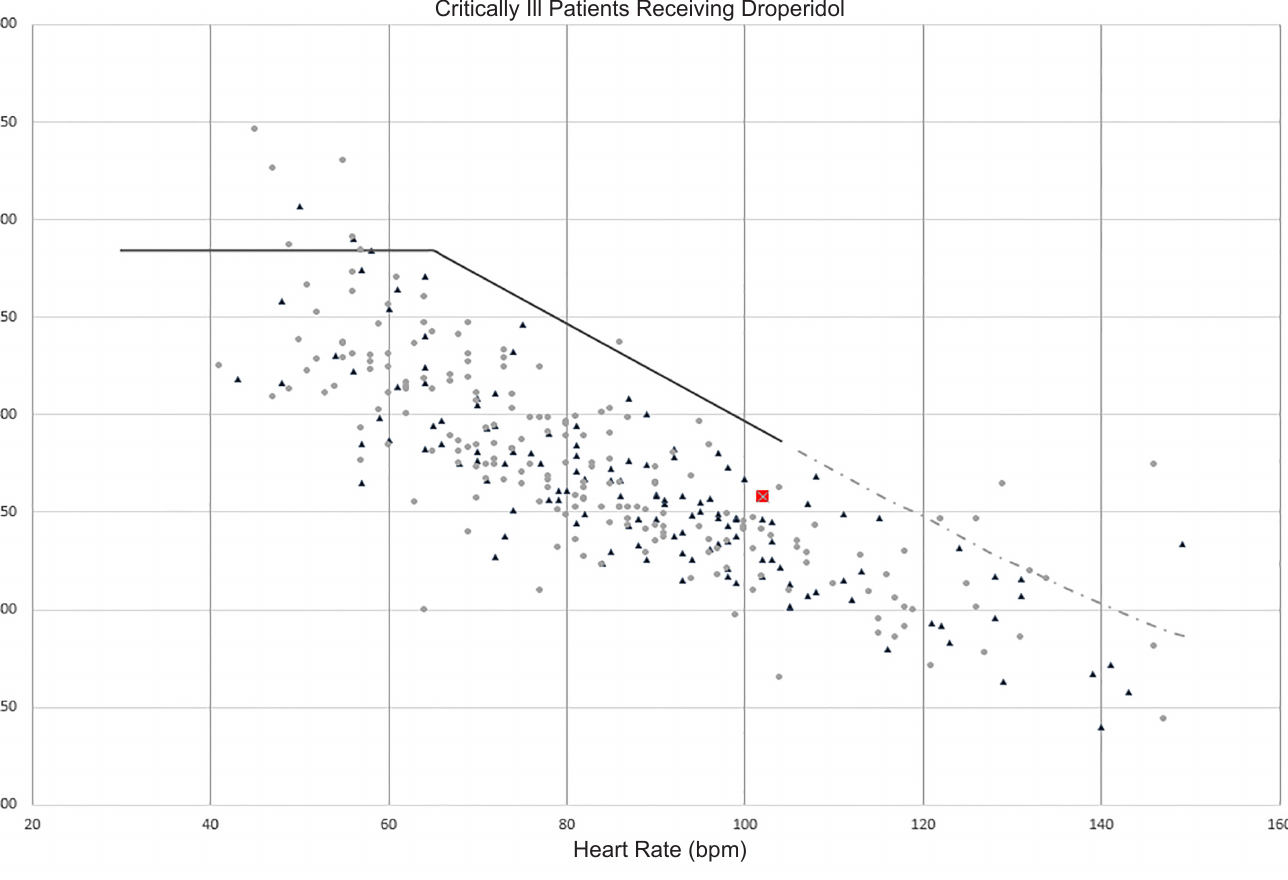
Figure 2. Heart rate and QT interval plotted on the QT nomogram. Data points above the line are considered “at-risk” for drug-induced torsades des pointes (TdP). Triangle represent electrocardiograms (ECG) obtained before patients received droperidol. Circles represent ECGs obtained after patients received droperidol. The lone square is the patient who experienced TdP; however, this ECG was obtained after defibrillation occurred and magnesium was administered. ECG , electrocardiogram; bpm , beats per minute; msec ,